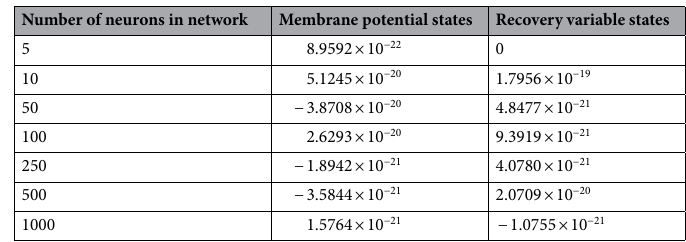
Table 4. Mean errors in the synchronization dynamics of the membrane potential states and recovery variable states for different-sized bidirectional networks of FHN neurons without noise.